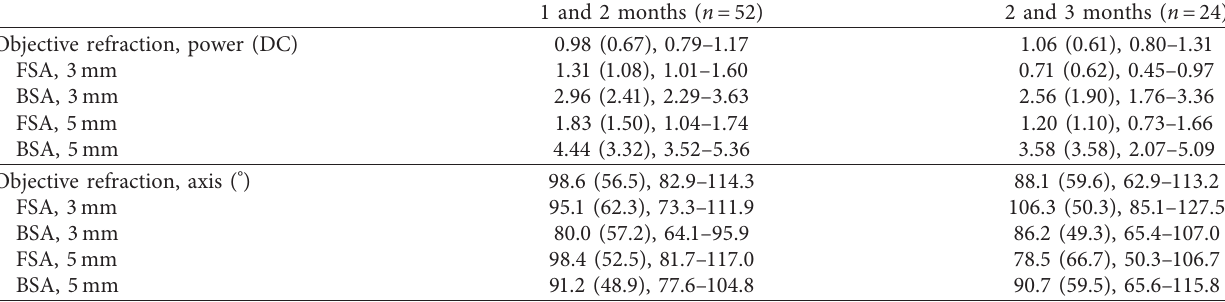
Table 1: Calculated change in the astigmatic power (DC, diopters) and axis ( ° ) with reference to the results obtained during objective refraction and Orbscan II analysis of the corneal back surface (CBS) over 3 and 5mm central zones.